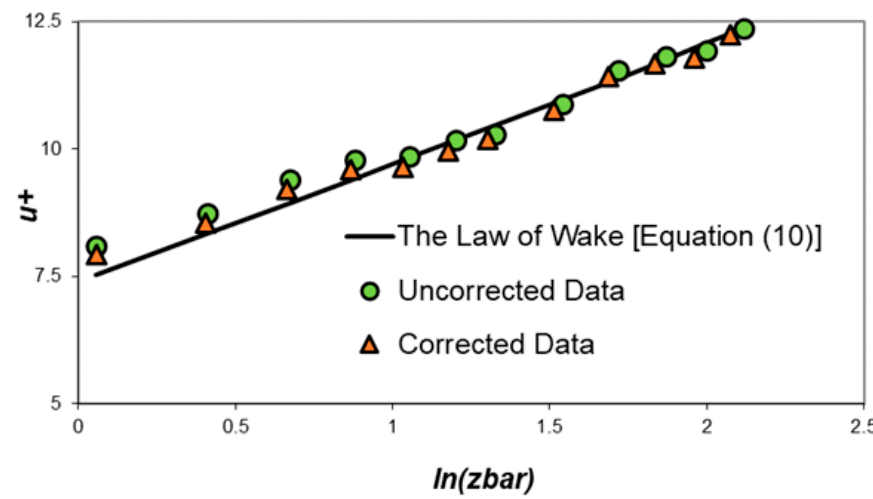
Figure 4. Normalised velocity profile over the laboratory-prepared well-packed rough bed.